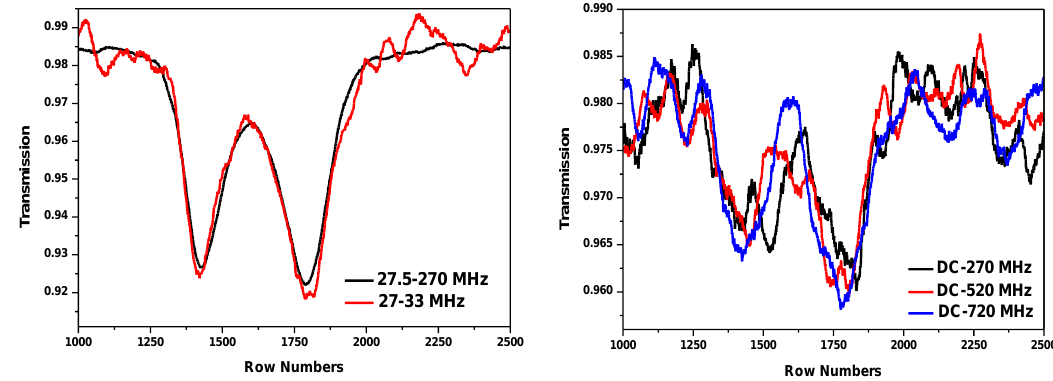
Figure 8. Heterodyne spectra of CH 4 extracted with different RF filter pass-bands. The noise level of the spectrum measured with the RF filter with a pass-band of 27.5–270 MHz (Figure 8 left, black) is lower than that measured with a pass-band of 27–33 MHz (Figure 8 left, red). Moreover, there is no obvious difference in the spectral line widths